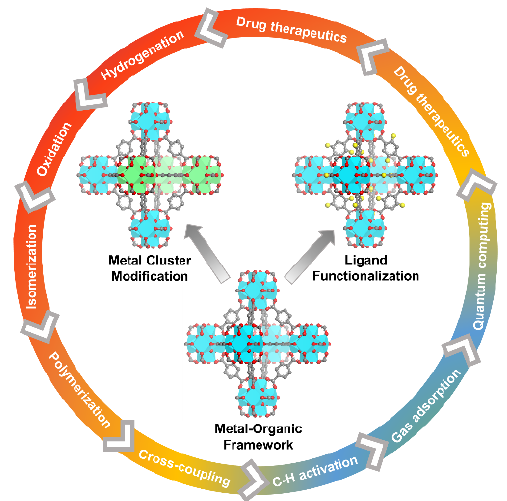
Figure 1. Summarizing figure of organometallic chemistry in metal–organic frameworks. Blue = Zr atoms. Green = Hf atoms. Red = O atoms. Grey = C atoms. Yellow = F atoms.